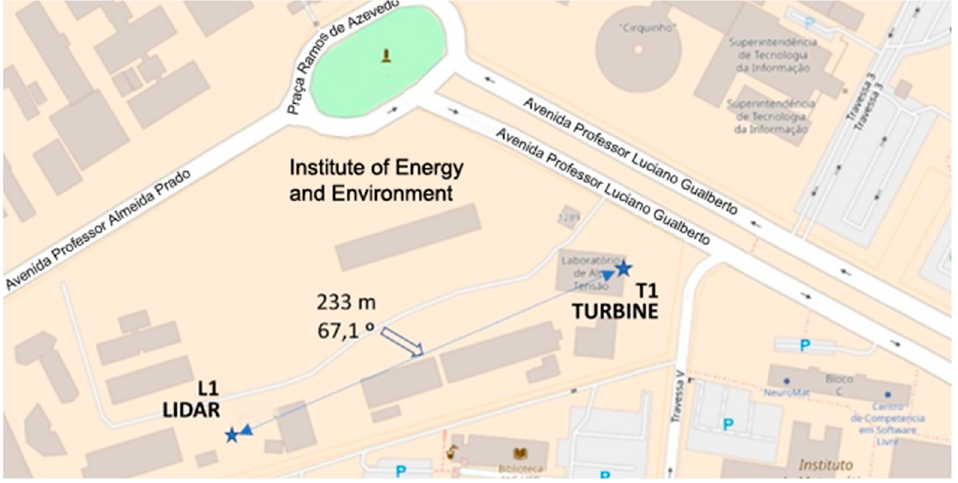
Figure 7. Installation site, L1: Lidar local, T1: Turbine local. Source: our elaboration using Windpro ® .